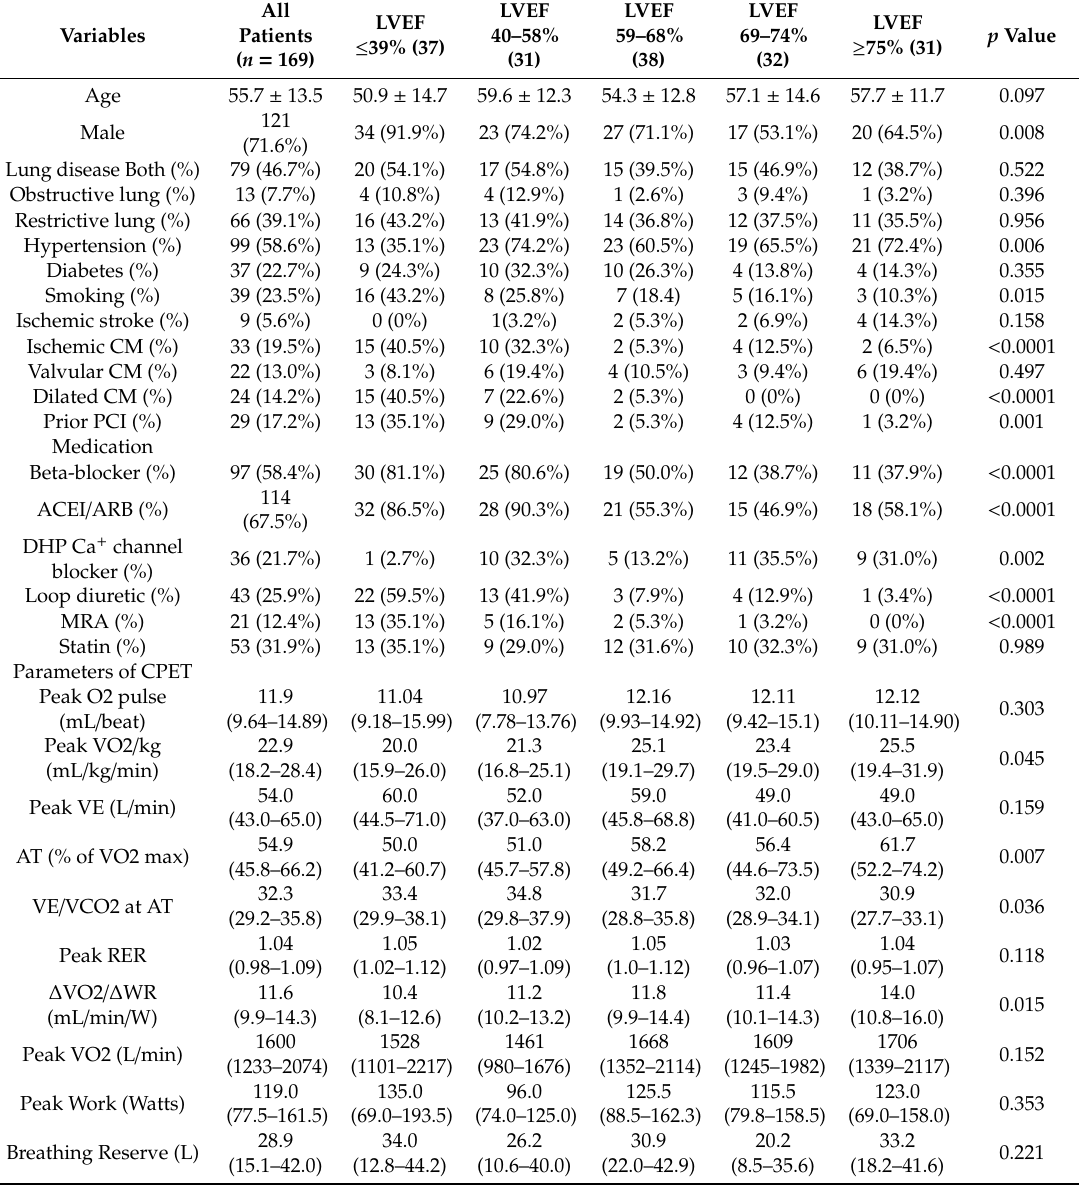
Table 1. Baseline clinical and pharmacological characteristics by